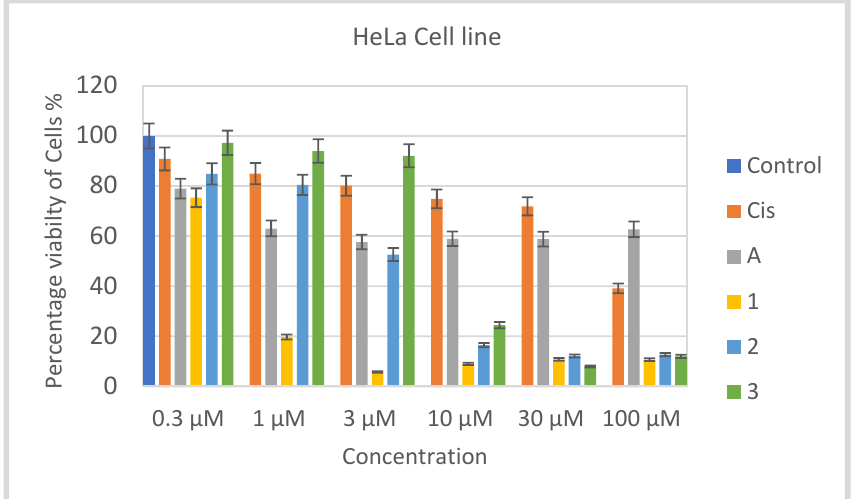
Figure 3. Effect of the concentration of complexes A, 1 – 3 and cisplatin on the viability of HeLa cells.